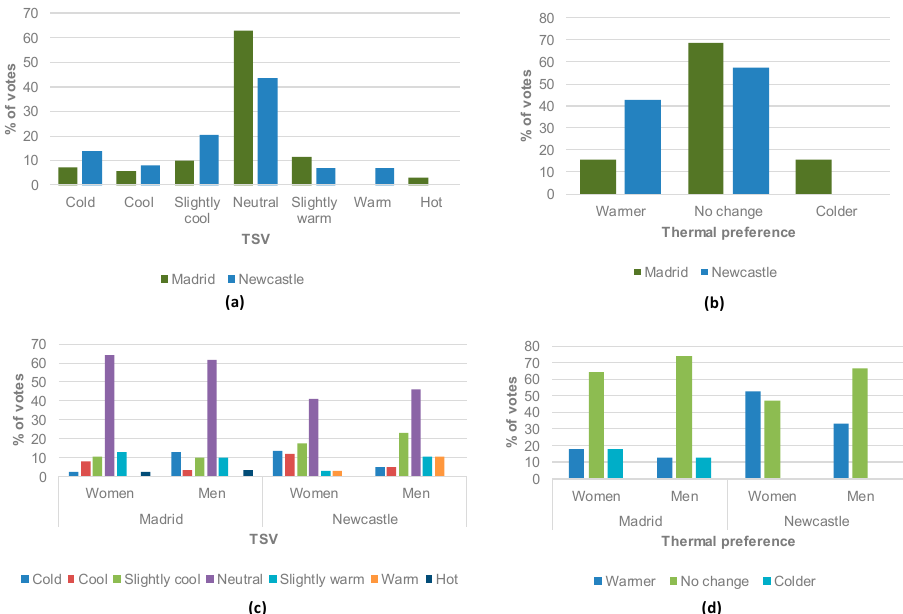
Figure 6. Thermal perception. ( a ) Thermal sensation (TSV) by city; ( b ) thermal preference by city; ( c ) thermal sensation by gender and city; ( d ) thermal preference by gender and city.